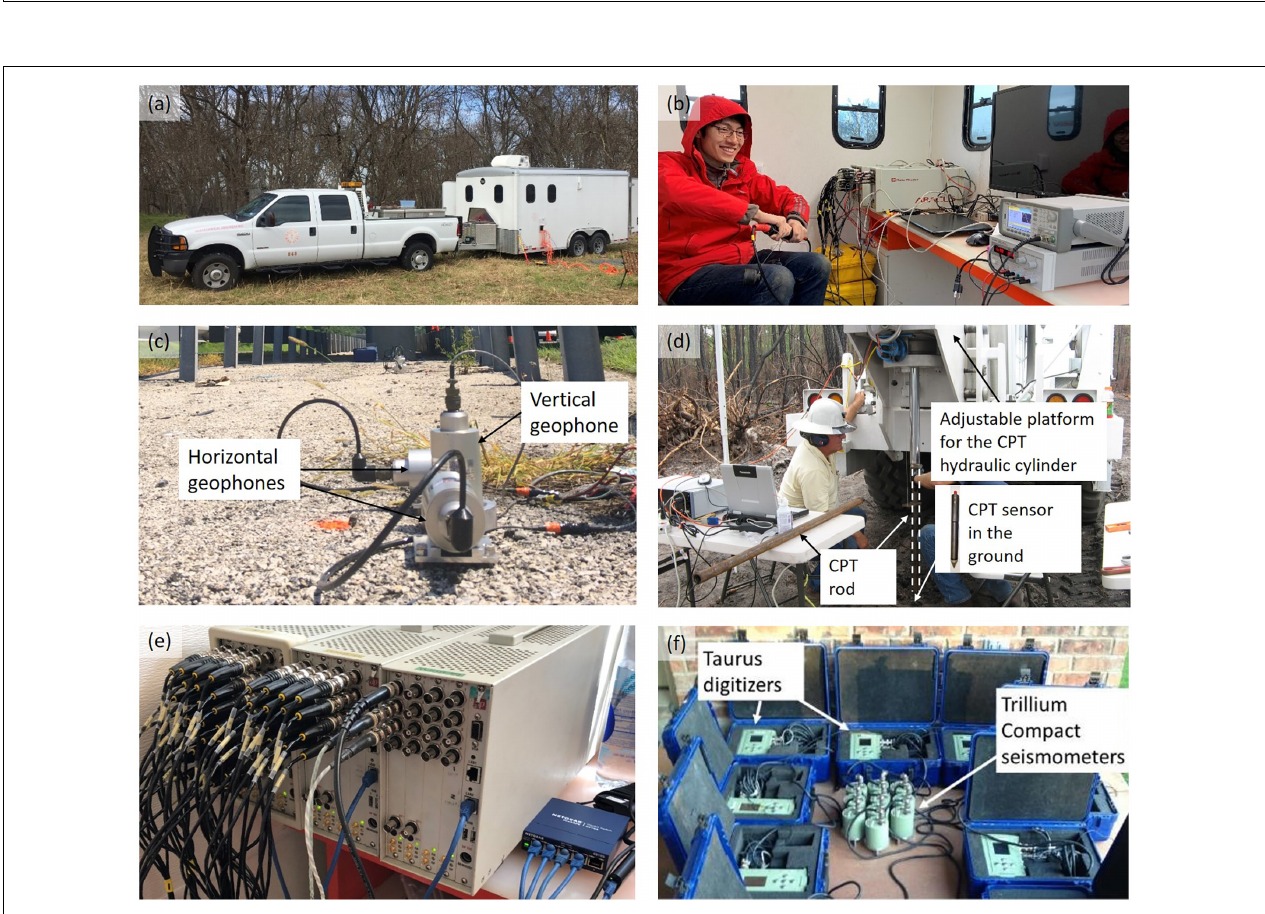
FIGURE 3 | Photographs of the field supply truck, mobile instrumentation trailer and some associated instrumentation available at NHERI@UTexas: (a) Field supply truck and instrumentation trailer, (b) Air-conditioned work space in instrumentation trailer, (c) 1-Hz vertical geophones and cables, (d) Cone penetrometer test equipment, (e) Data Physics analyzers, and (f) Trillium Compact Seismometers and Taurus Digitizers (after Stokoe et al., 2017).